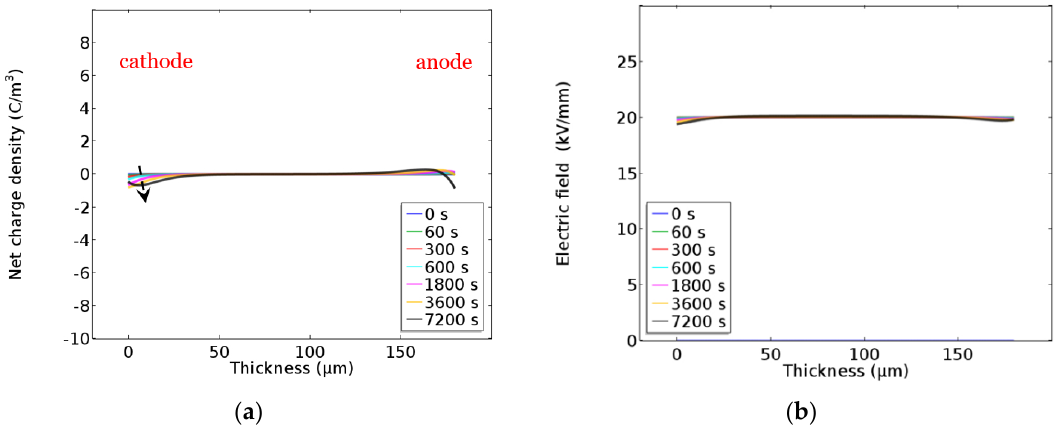
Figure 10. ( a ) Space charge accumulation simulated by the modified model in degassed XLPE sample at 20 kV/mm field. ( b ) Electric field distribution across the degassed XLPE film.